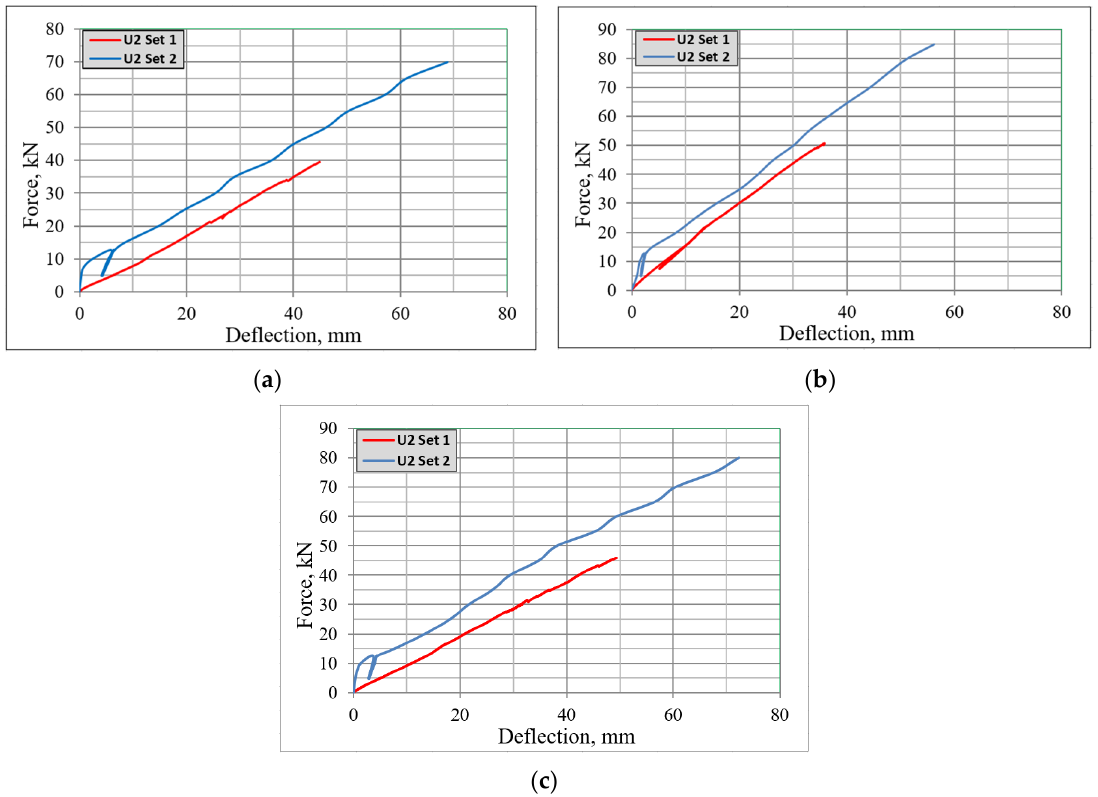
Figure 10. Comparison of the ultimate capacity for beams from Set 1 and Set 2; ( a ) B2Ø14, ( b ) H2Ø14, ( c ) N2Ø14.